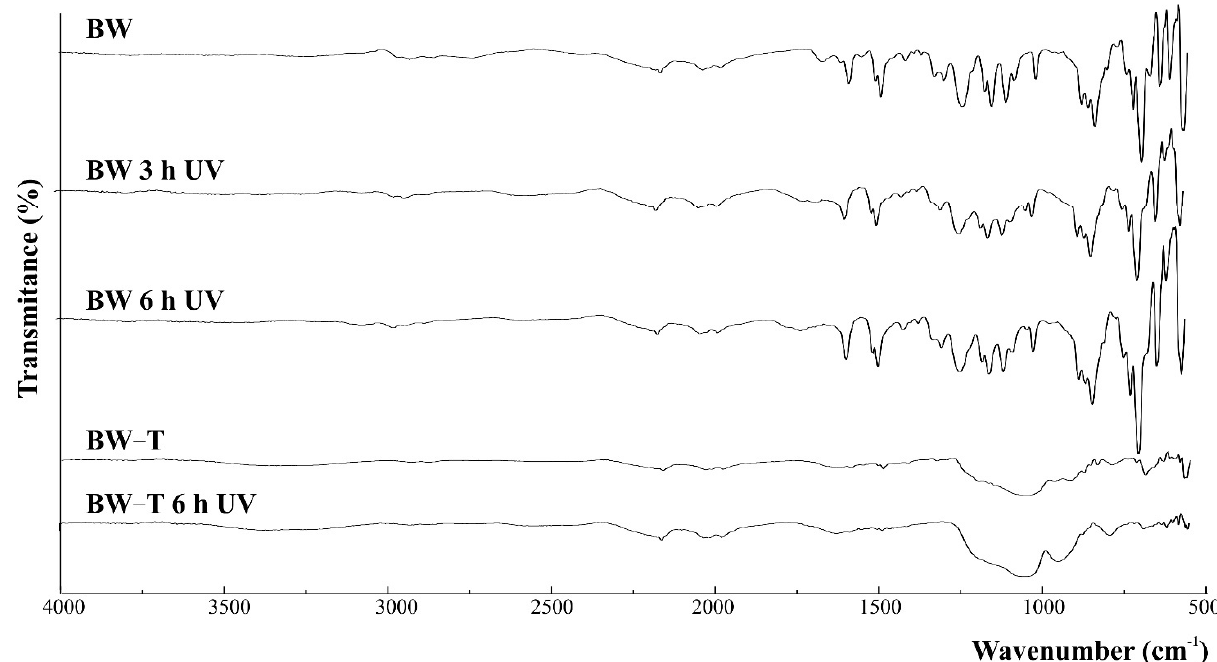
Figure 5. ( A – D ) SEM images for BW and BW-T (BW modified with TiO 2 ) membranes before and after UV exposure (magnification ×3000), ( E ) BW-T EDS, ( F ) EDS mapping showing the Ti distribution on the membrane surface after 6 h UV exposure, and ( G ) Fourier transform infrared spectroscopy (FTIR) spectra for BW and BW-T membranes before and after 3 and 6 h of UV radiation.